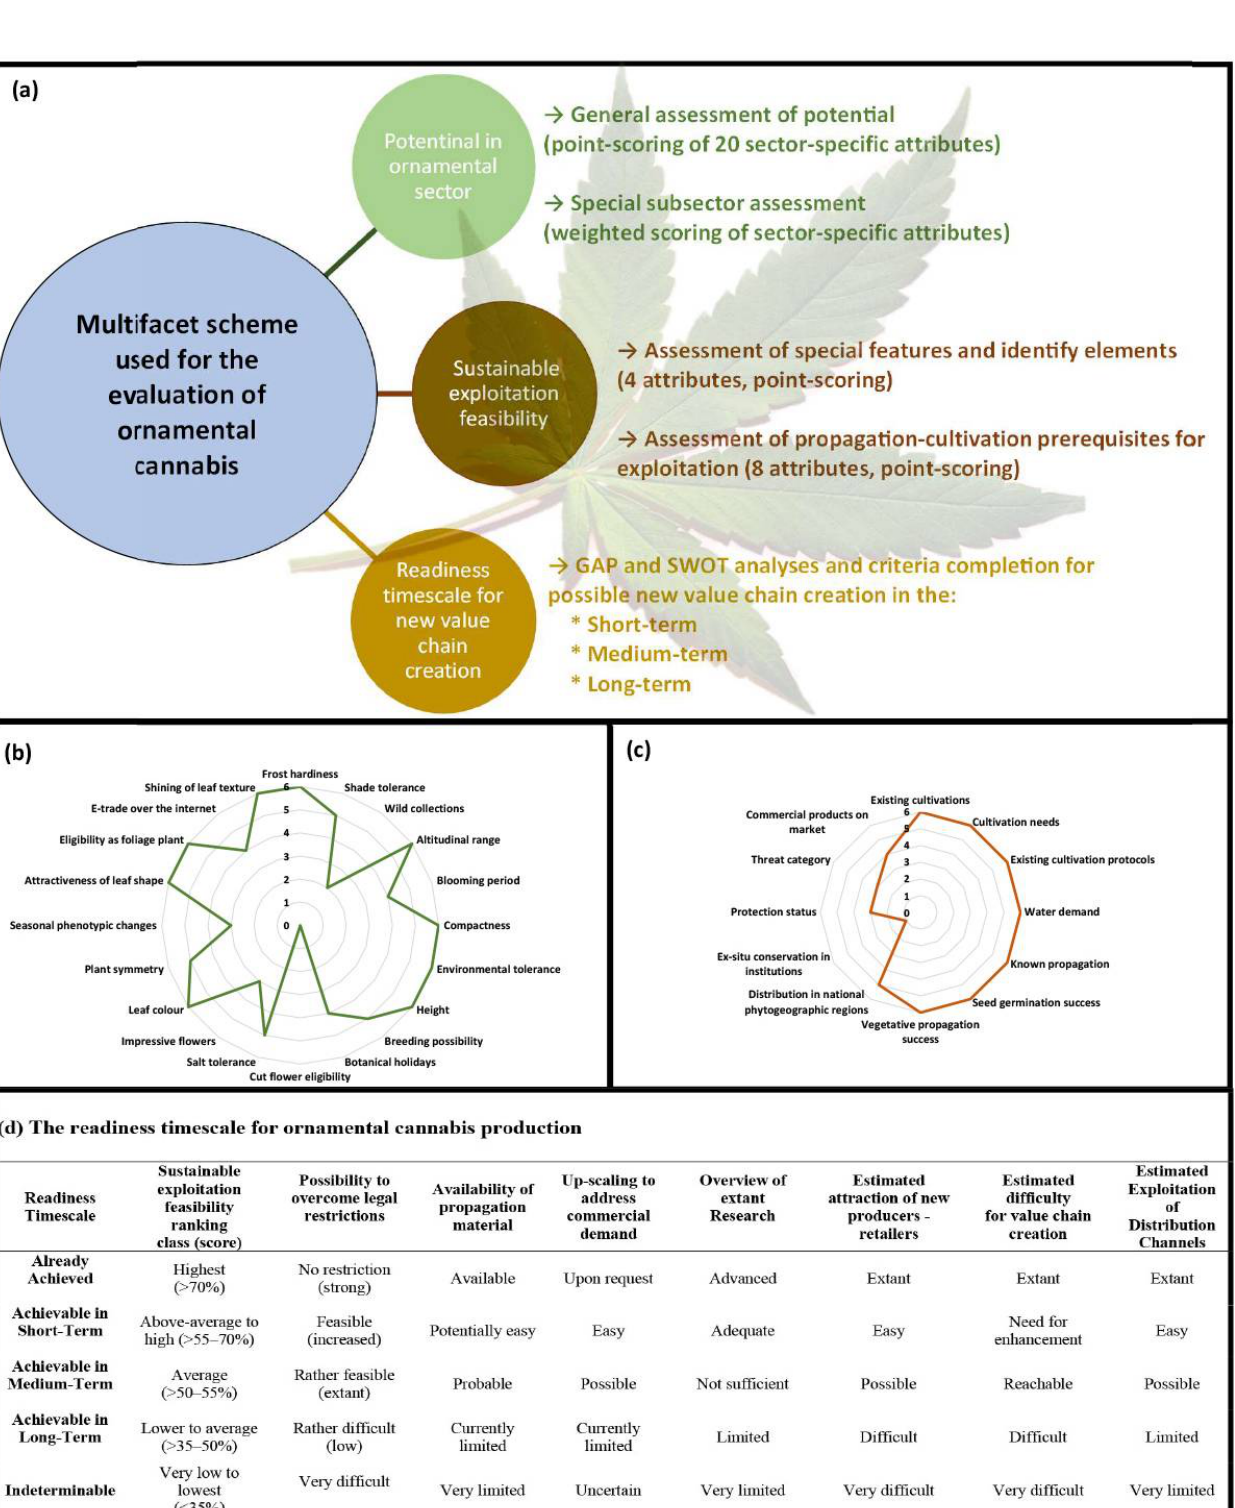
Figure 2. A schematic representation of the methodology for evaluating cannabis to introduce as an ornamental crop. ( a ) simplified schematic view of the multifaceted criteria at three levels for assessing cannabis in the ornamental industry, ( b ) evaluation of cannabis ornamental potential based on twenty attributes, ( c ) evaluation of cannabis sustainable exploitation feasibility based on twelve attributes, and ( d ) requirements of the readiness timescale for ornamental cannabis production. To evaluate the ornamental potential of cannabis as a potted plant, the following equation was used: